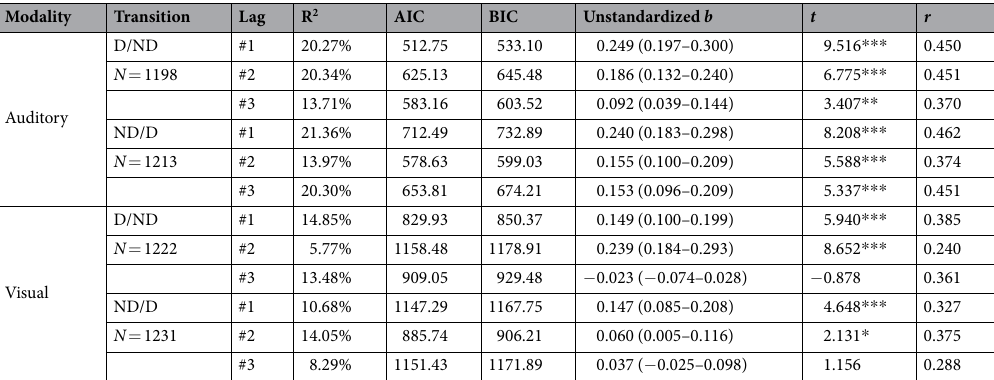
Table 1. Relationship between successive phase durations in the auditory and visual modalities. “Transition” refers either to the Dominant/Non-Dominant (D/ND) or the Non-Dominant/Dominant (ND/D) transitions. “Lag” refers to the number of intervening percept durations: for example, lag 1 refers to the correlation with the percept duration immediately following each individual duration. R 2 refers to the explained variance of the model, whereas AIC and BIC refer to the Akaike or Bayesian Information Criterion, respectively. “Unstandardized b” refers to the slope of the model with CI 95 values included in parenthesis. “t” refers to the t-test examining the slope’s difference from zero and asterisks are indicating the level of significance ( *** p < 0.001, ** p < 0.01, * p < 0.05). “r” refers to the correlation coefficient between the two phases estimated from the R 2